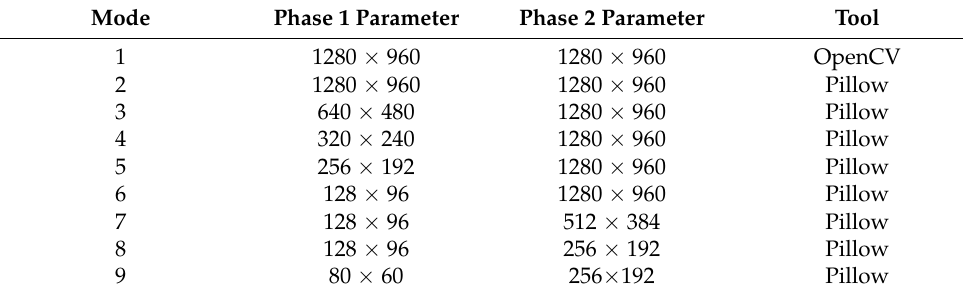
Table 5. Initial Parameter combination.